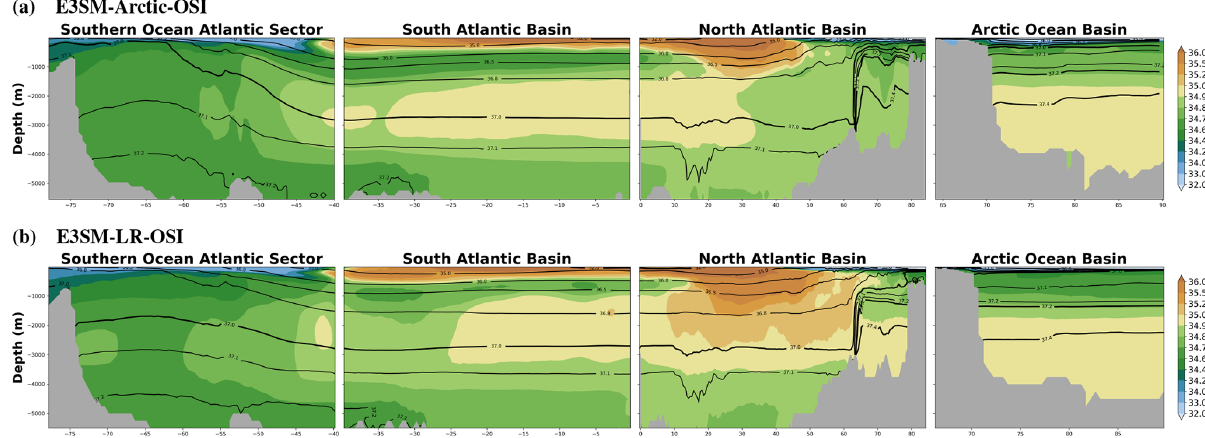
Figure 6. Meridional vertical section of zonally averaged salinity field, where the zonal average is computed over the Atlantic sector of the global ocean and over the whole Arctic Ocean north of approximately the latitude of Fram Strait, from (a) E3SM-Arctic-OSI and (b) E3SM- LR-OSI. Contour lines follow the sigma2 field (potential density with respect to 2000m). All fields are climatologies over years